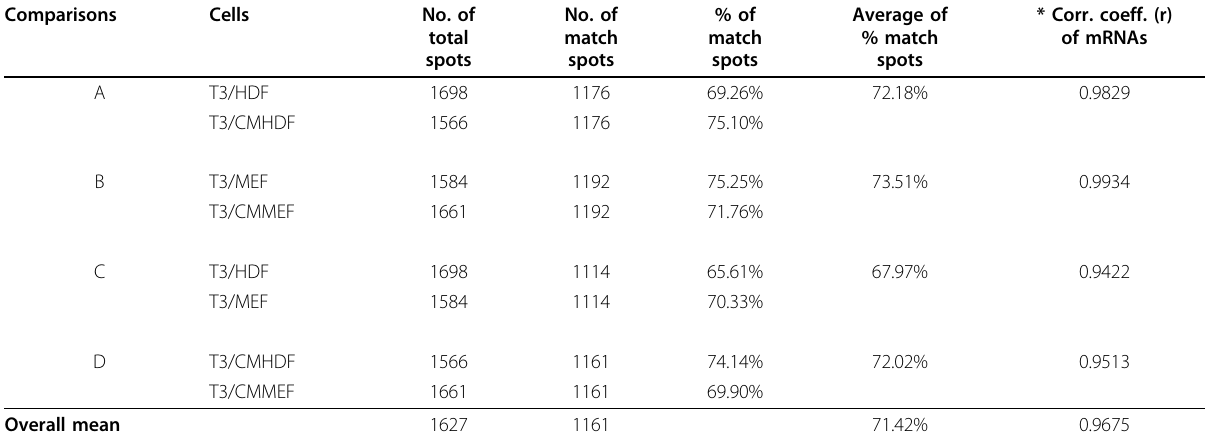
Table 3 Similarities among expressions of protein spots and mRNAs of T3/HDF, T3/CMHDF, T3/MEF and T3/CMMEF